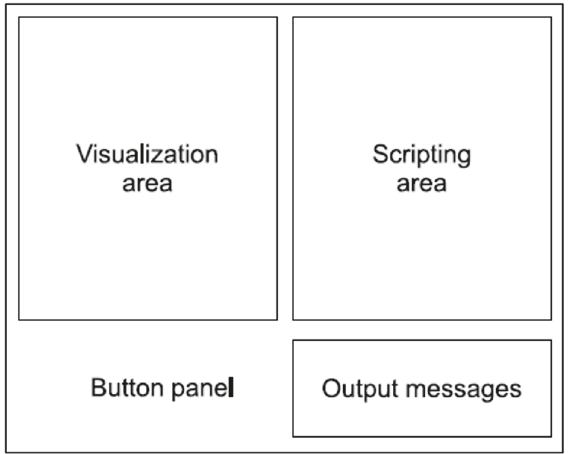
Figure 4: Layout of the user